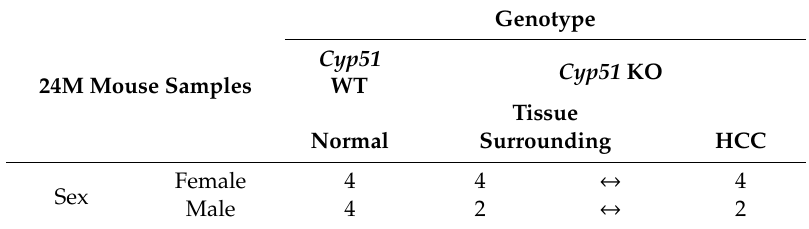
Table A3. Number of 24M mouse samples for DNA-microarray analysis. ↔ indicates related samples, i.e., di ff erent tissue samples obtained from individual